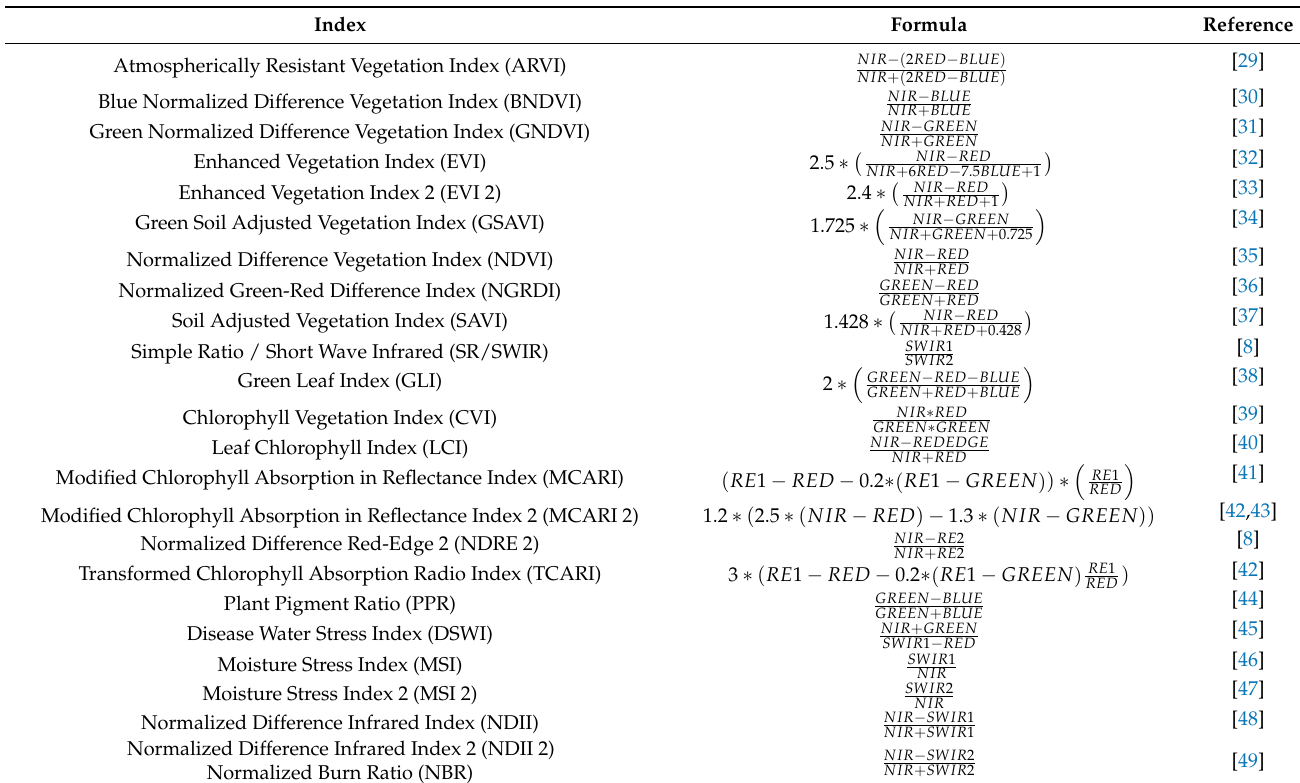
Table 3. Remote sensing indices used for forest analysis. Explanation: blue: Sentinel-2 band no. 2, green: 3, red: 4, Red Edge (RE1): 5, Red Edge (RE2): 6, REDEDGE: 7, NIR: 8, SWIR1: 11, SWIR2: 12. Index Formula Reference Atmospherically Resistant Vegetation Index (ARVI) NIR − ( 2 RED − BLUE ) NIR +( 2 RED − BLUE ) Blue Normalized Difference Vegetation Index (BNDVI) Green Normalized Difference Vegetation Index (GNDVI) Enhanced Vegetation Index (EVI) Enhanced Vegetation Index 2 (EVI 2) Green Soil Adjusted Vegetation Index (GSAVI) Normalized Green-Red Difference Index (NGRDI) Soil Adjusted Vegetation Index